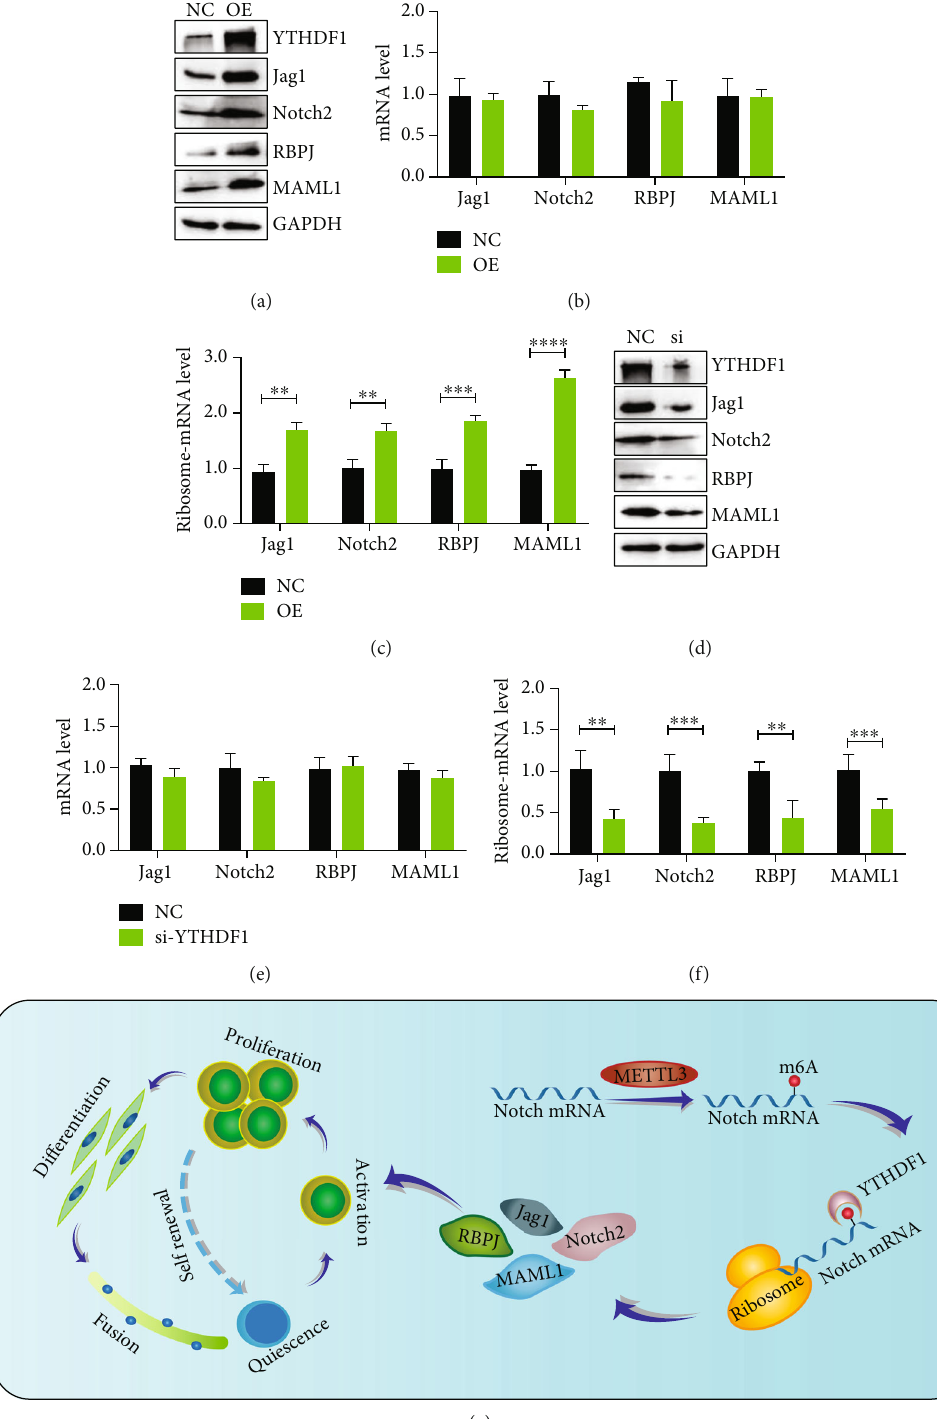
Figure 7: YTHDF1 regulates the mRNA translation e ffi ciency of Notch signaling pathway components. (a) The protein levels of Notch signaling pathway in the METTL3 overexpressed or (d) depleted and control cells. (b, e) mRNA expression of Notch signaling pathway analyzed by q-PCR. (c, f) Polyribosome-bound mRNA-qPCR was used to detect translation e ffi ciency. (g) Working model of METTL3 regulates muscle stem cells by Notch signaling pathway. ∗∗∗∗ p < 0 : 0001 ; ∗∗∗ p < 0 : 001 ; ∗∗ p < 0 : 01 . NC: negative control; OE: YTHDF1 overexpressed; si: YTHDF1